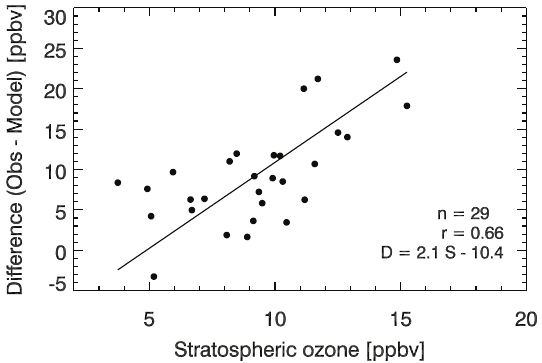
Figure 12. Predictability of model bias during high-ozone events (MDA8 ozone >70ppbv) at CASTNet sites in the Intermountain West in spring 2006. The figure shows a scatterplot of the GEOS- Chem low bias (observation minus model difference) vs. strato- spheric ozone influence simulated by the model as ozone produced in the stratosphere. The black line shows the reduced-major-axis re- gression line. The number of occurrences, correlation coefficient, and the regression results are shown